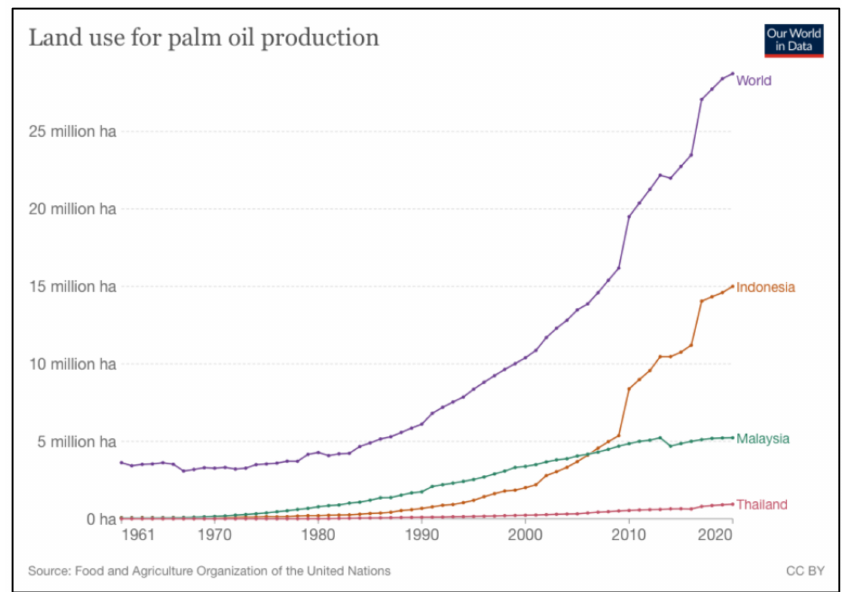
Figure 1. Change in land use for palm oil production (Source: Our World in